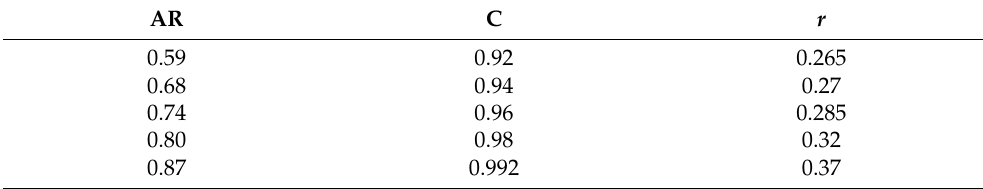
Figure 4. Numerical calibration model in PFC2D. Table 1. Descriptors for particle clumps in the numerical calibration